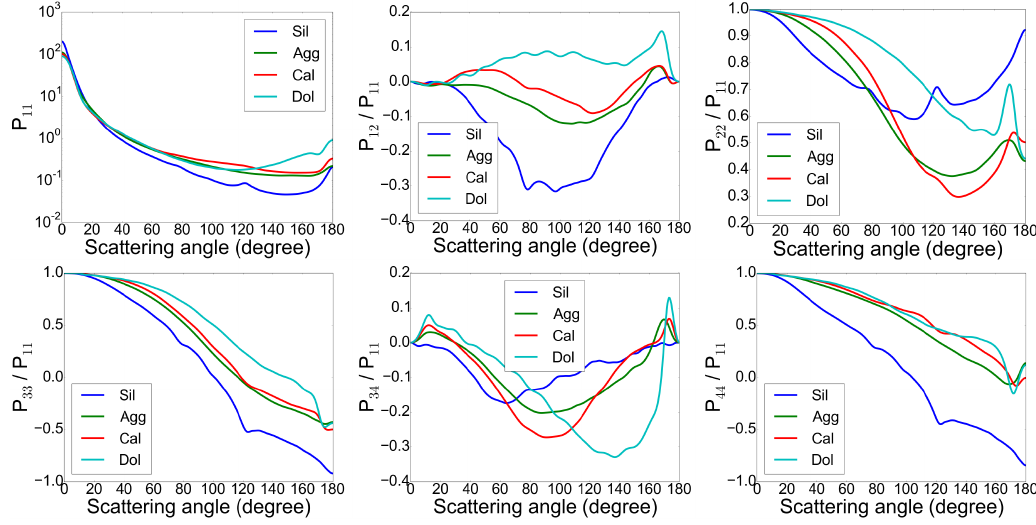
Figure 2. The six independent non-zero scattering matrix elements of the target particles integrated over the size